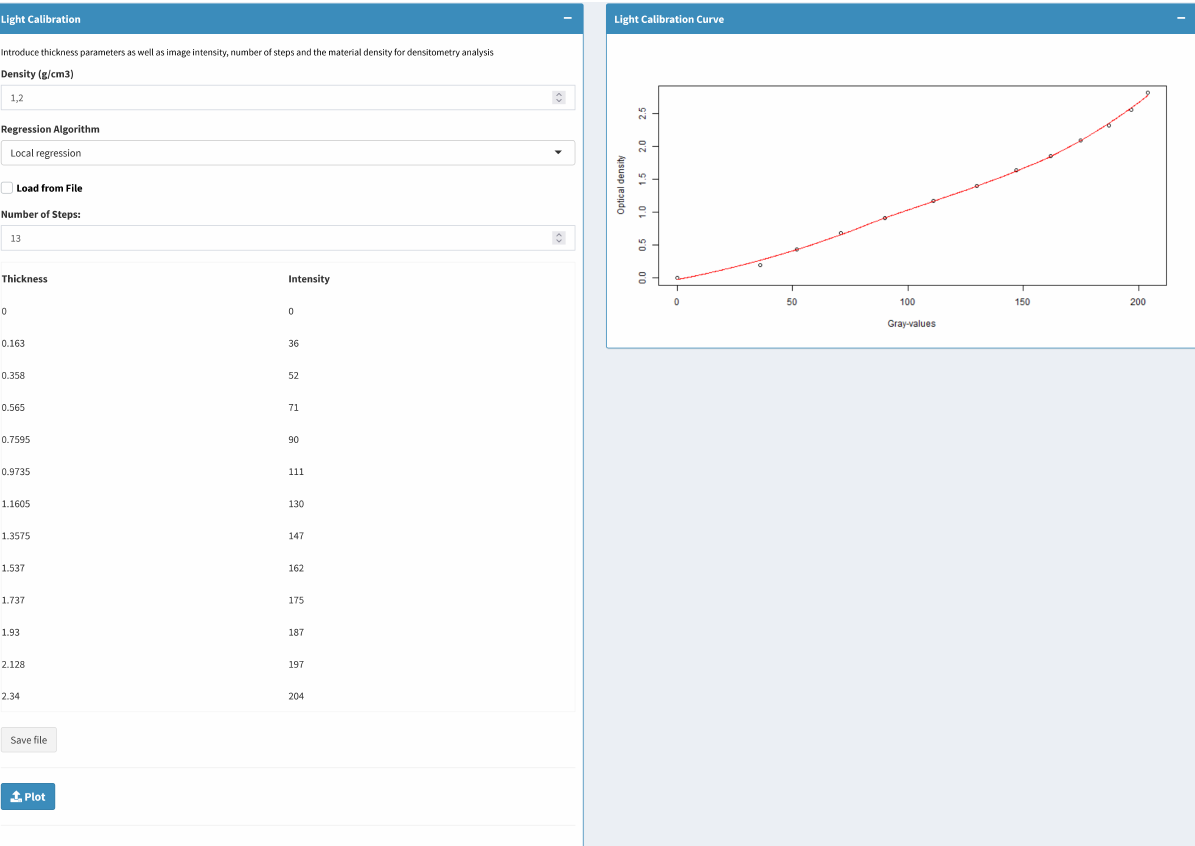
Figure 1. Light Calibration configuration. On the left, density and gray values from stepped calibration wedge and selection of the regression mode. On the right, graphic representation of known density data and its local regression